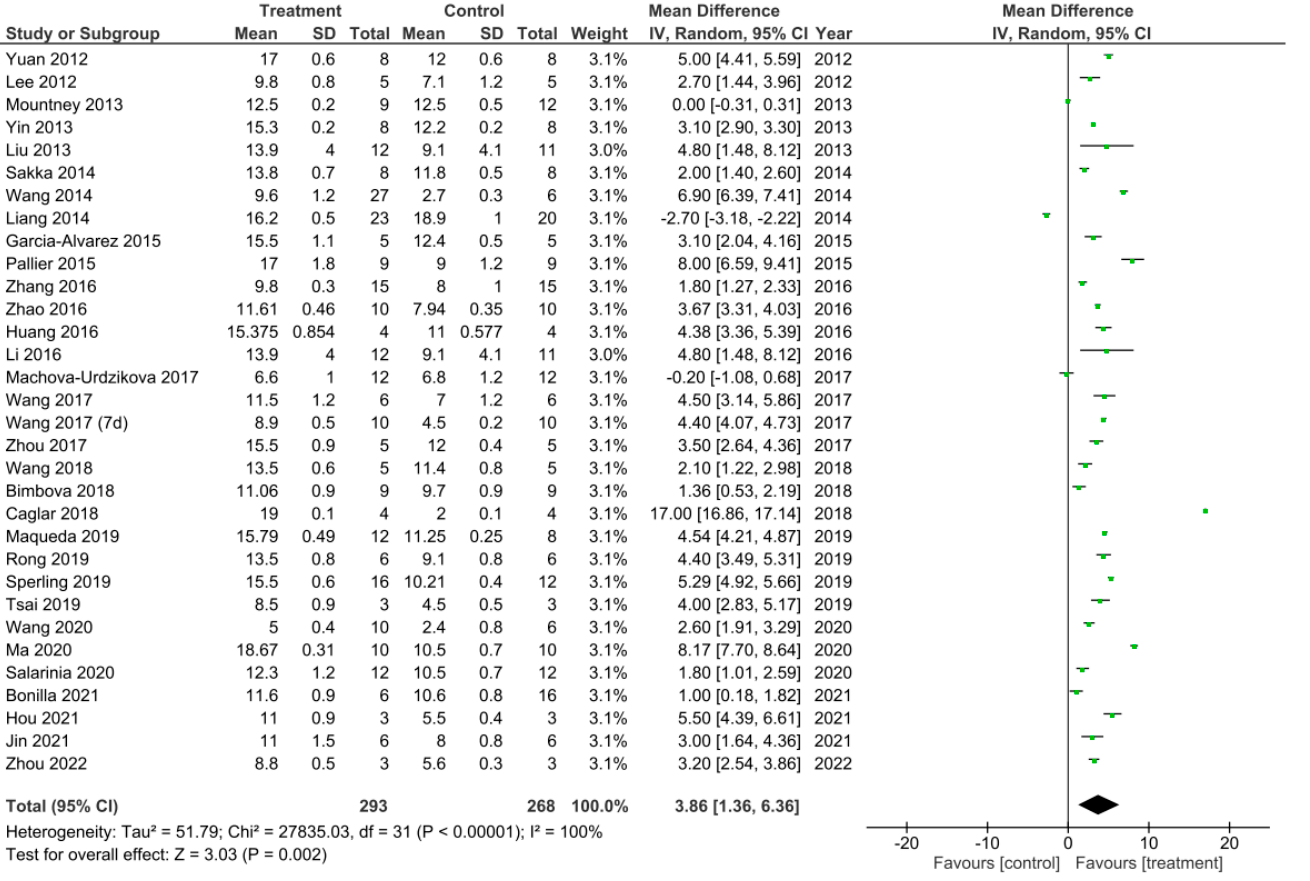
Figure 7. A meta-analysis for the effect of all treatments on the improvement of BBB scores analysed at the final recorded timepoints after spinal cord injury in all 32 studies that performed the BBB test